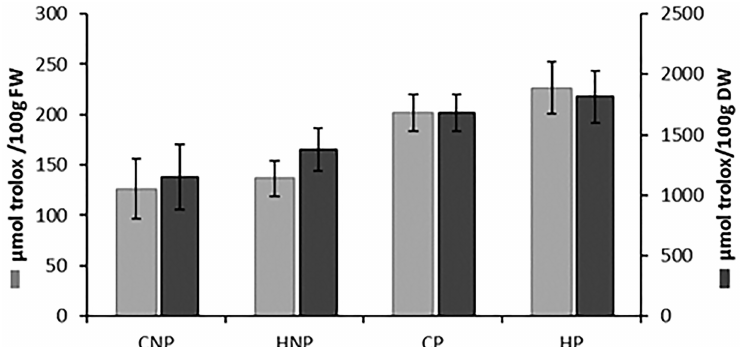
Fig 6. TEAC of Strychnoscocculoides juice. Data are expressed as μ mol trolox/ 100 g ± standard error. CNP: Cold water extraction without pectinase, HNP: Hot water extraction without pectinase, HP: Hot water extraction with pectinase, CP: Cold water extraction with